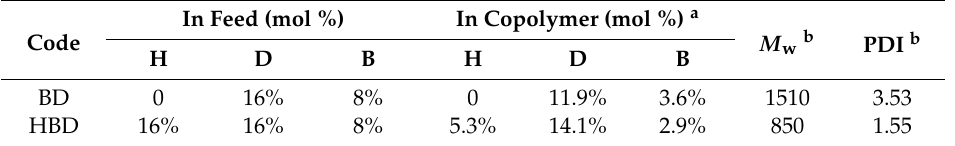
Table 1. Composition of BD and HBD copolymers.